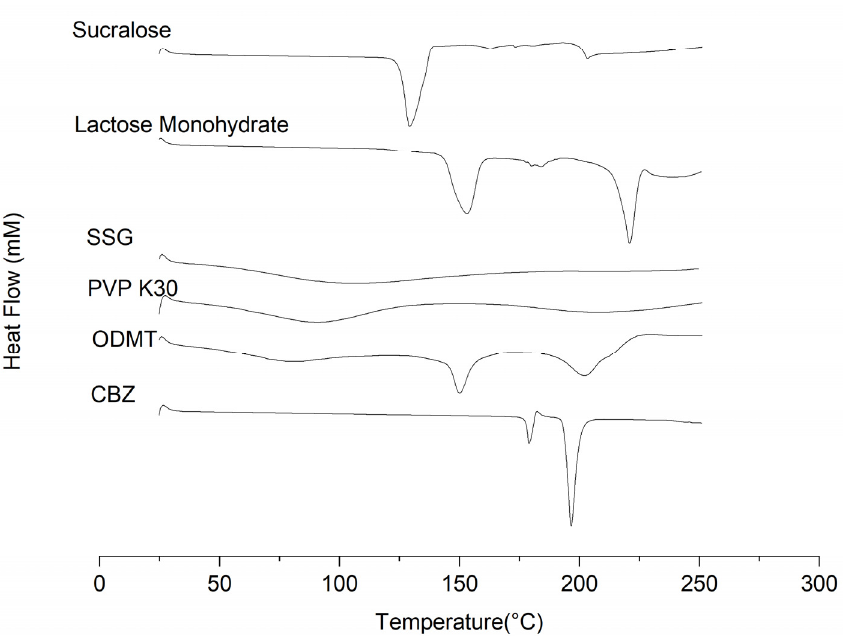
Figure 11. DSC thermogram of lactose monohydrate, PVP K30, SSG, sucralose, drug-loaded wet mass and drug-loaded ODMTs.